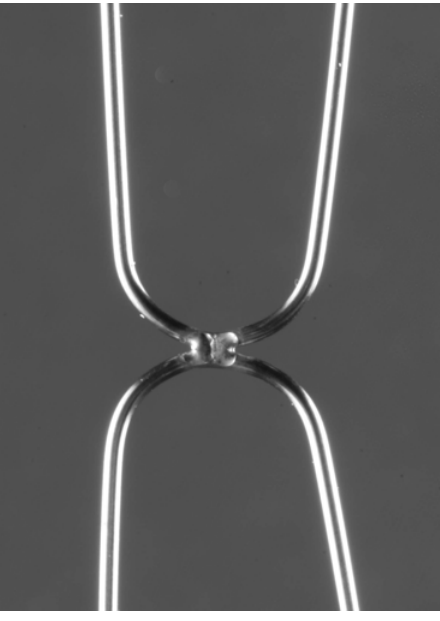
FIGURE 2- Cross joints. Wire material: Forestanit in spring hard quality (diameter 0.9 mm)